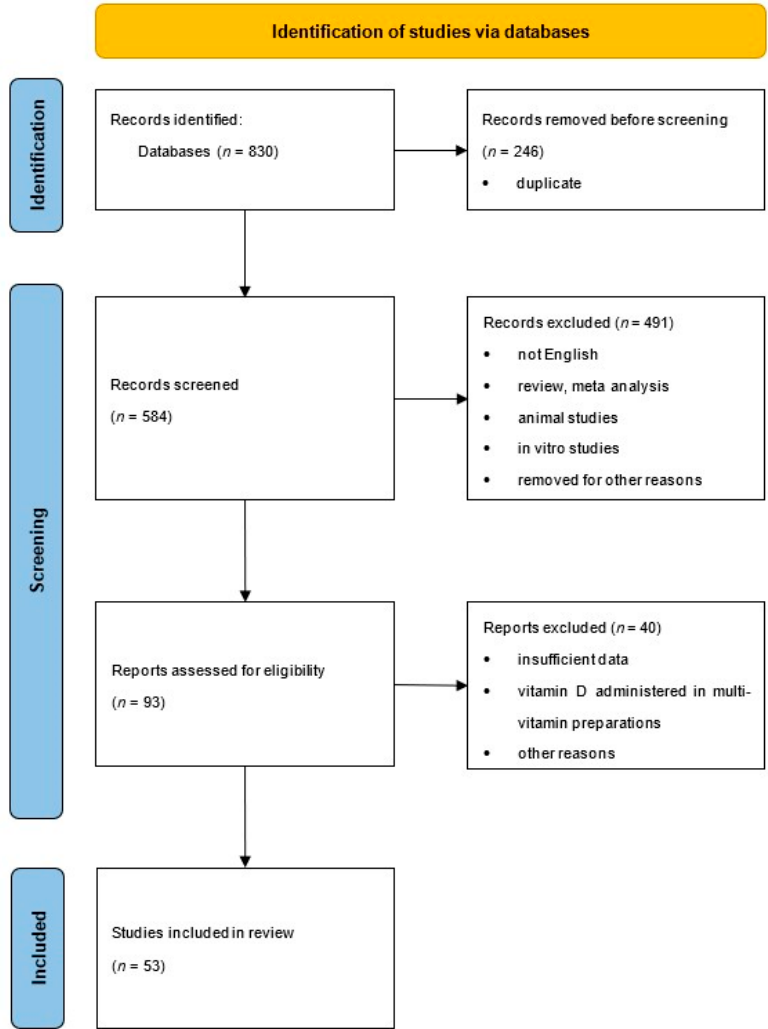
Figure 2. PRISMA flow chart of the literature search and screening process.